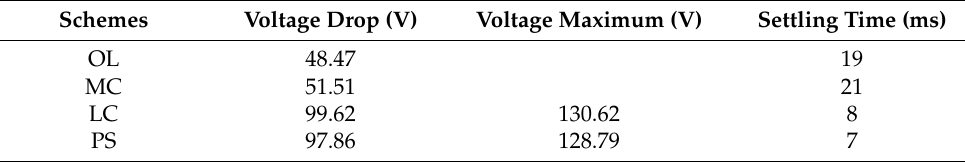
Table 3. Simulation results of the voltage drop and settling time between different schemes.